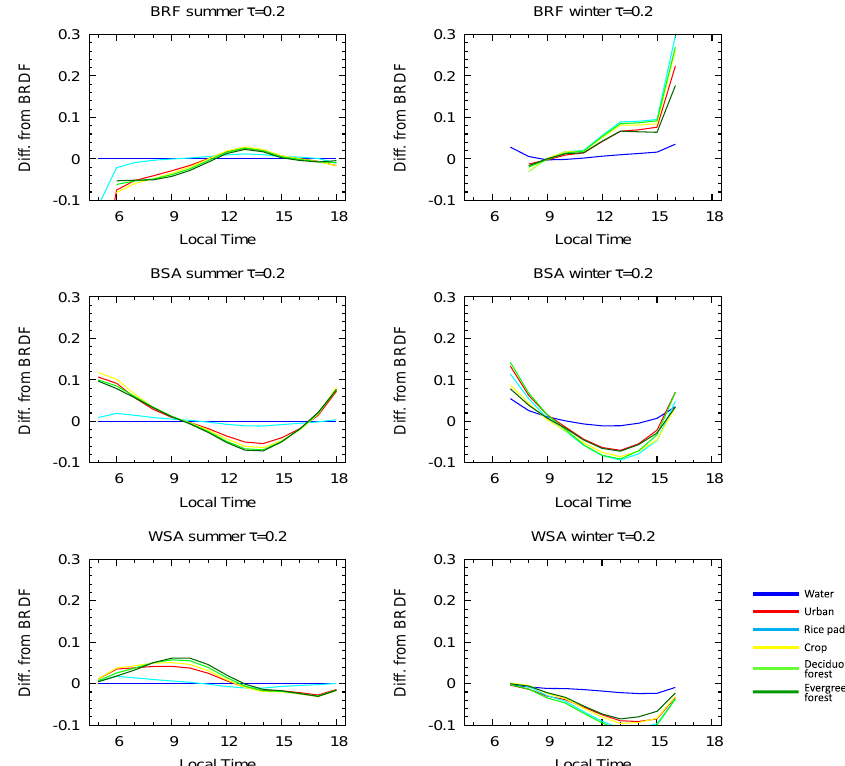
Figure 7. Relative difference of tropospheric NO 2 AMFs from the value obtained with full BRDF treatment when implementing the values of BRF (top), BSA (middle), and WSA (bottom) surface as LER in the RTM in summer (left) and winter (right). The colors indicate land cover types: water (blue), urban (red), rice paddy (light blue), crop (yellow), deciduous forest (light green), and evergreen forest (green). An aerosol optical depth (AOD) of 0.2 is assumed.